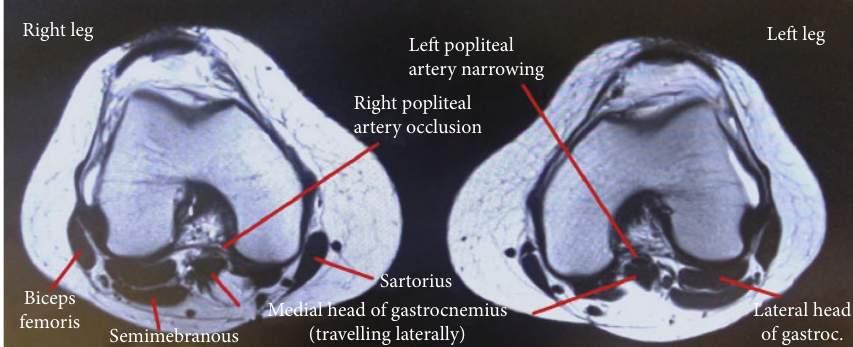
Figure 2: Magnetic resonance imaging demonstrating an axial view of bilateral knees. Note the lateral travel of the medial head of gastrocnemius, resulting in a right popliteal artery occlusion and left popliteal artery high-grade